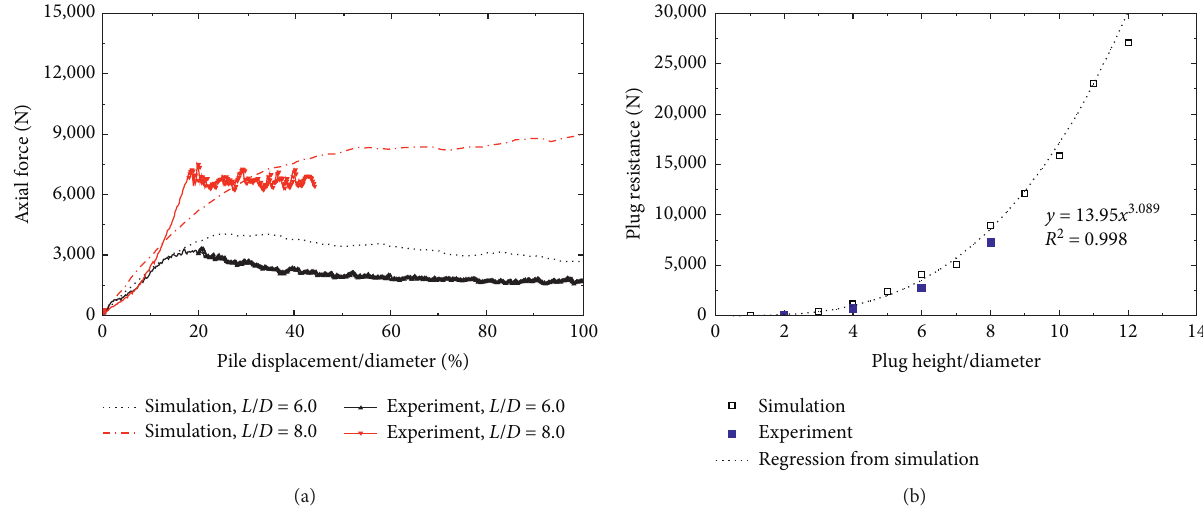
Figure 7: Experimental and simulation results of pipe piles with different plug length-diameter ratios: (a) examples of force-displacement curves and (b) plug resistance over different L / D s ( D � 5.0cm).